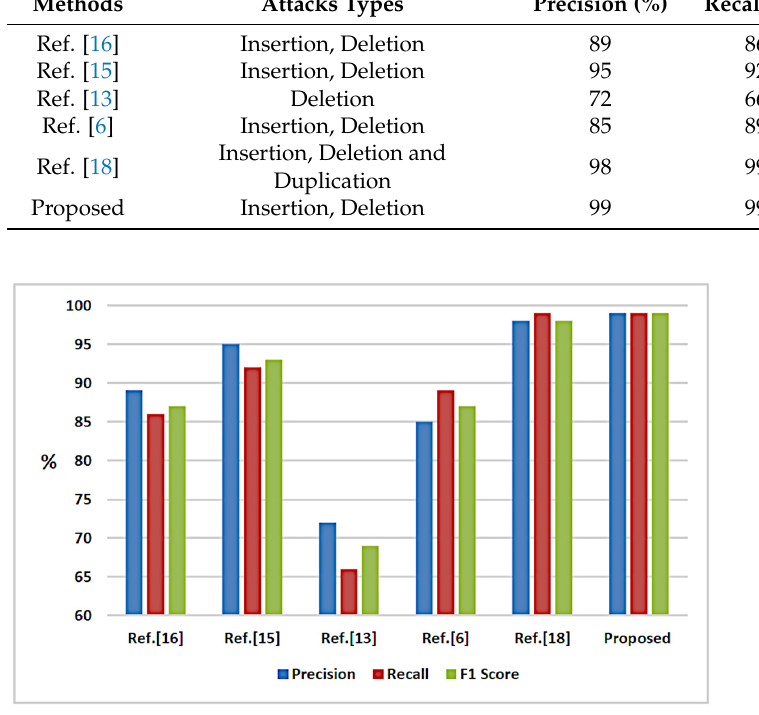
Figure 10. Performance chart of proposed approach compared with other related methods.